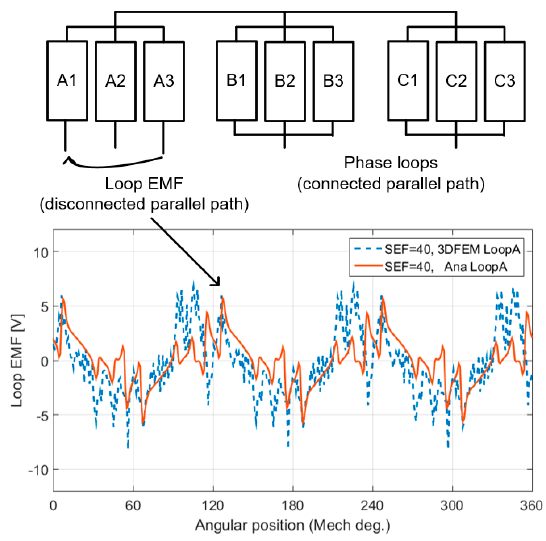
Figure 19. Connections among the phase to form the phase winding ( up ) and the waveforms of the loop EMFs of phase A during one complete rotor revolution at rated speed ( down ).